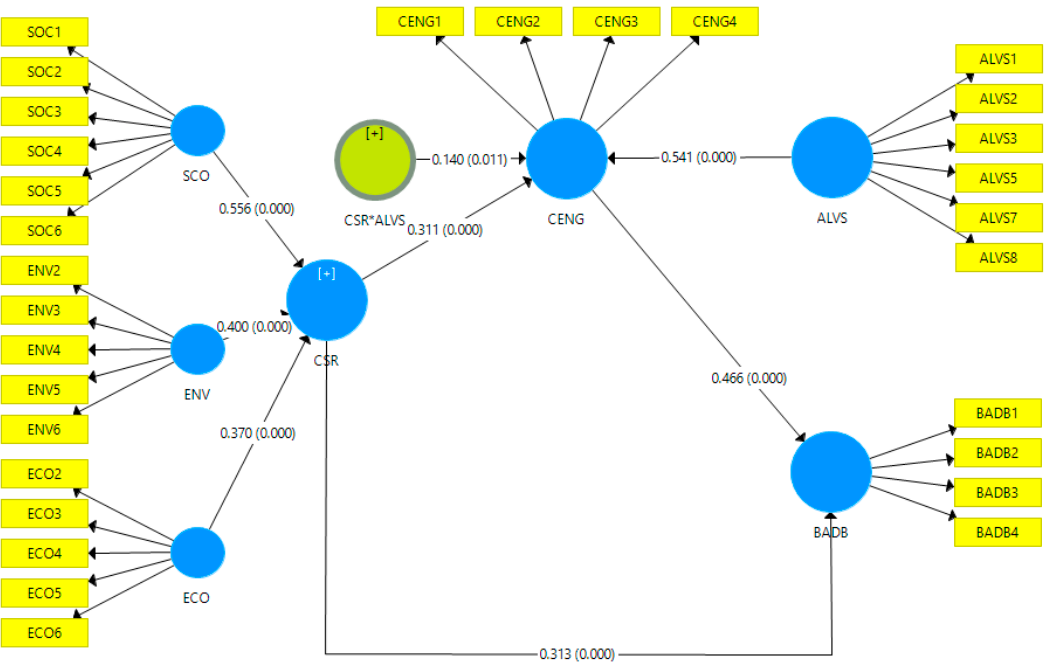
Figure 3. The structural model image extracted from SMART-PLS: CSR = Corporate social responsibility, ALVS = Altruistic values, CENG = Consumer engagement, BADB = Brand advocacy behavior, SCO = Social dimension, ENV = Environmental dimension, ECO = Economic dimension. Table 7. Structural analysis.